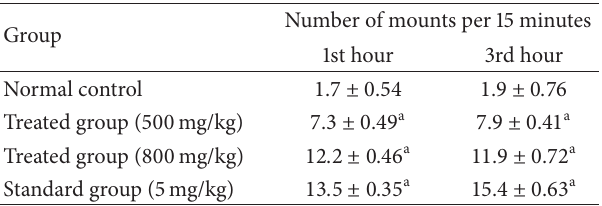
Table 2: Effect of Cydonia oblonga on the mounting behaviour of male rats on the 28th day of the study.